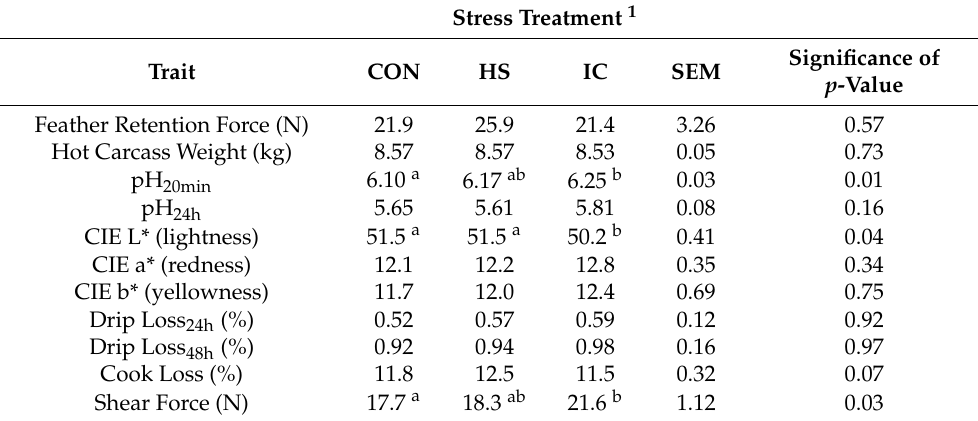
Table 9. Harvesting and meat quality attributes of turkey meat subjected to environmental stress 1 week prior to harvest.